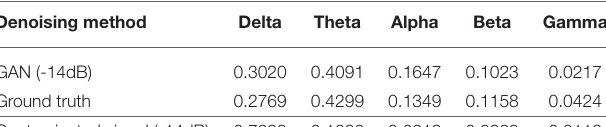
TABLE 1 | Power ratios of different frequency bands before and after EOG artefact removal. Denoising method